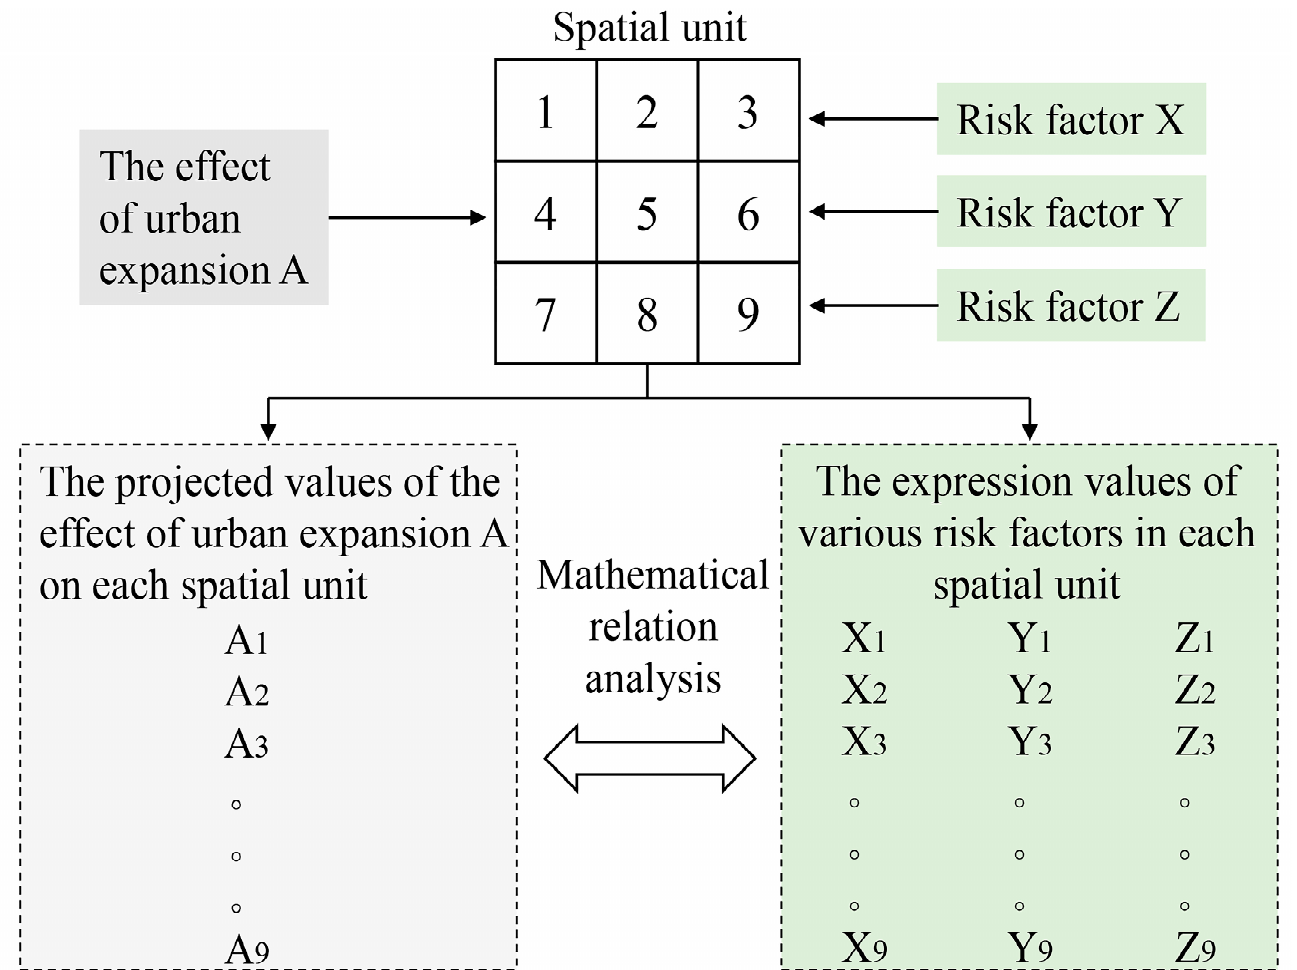
Figure 3. The principle of mathematical correlation analysis between urban expansion and the rural systemic risk (source: self-drawn).